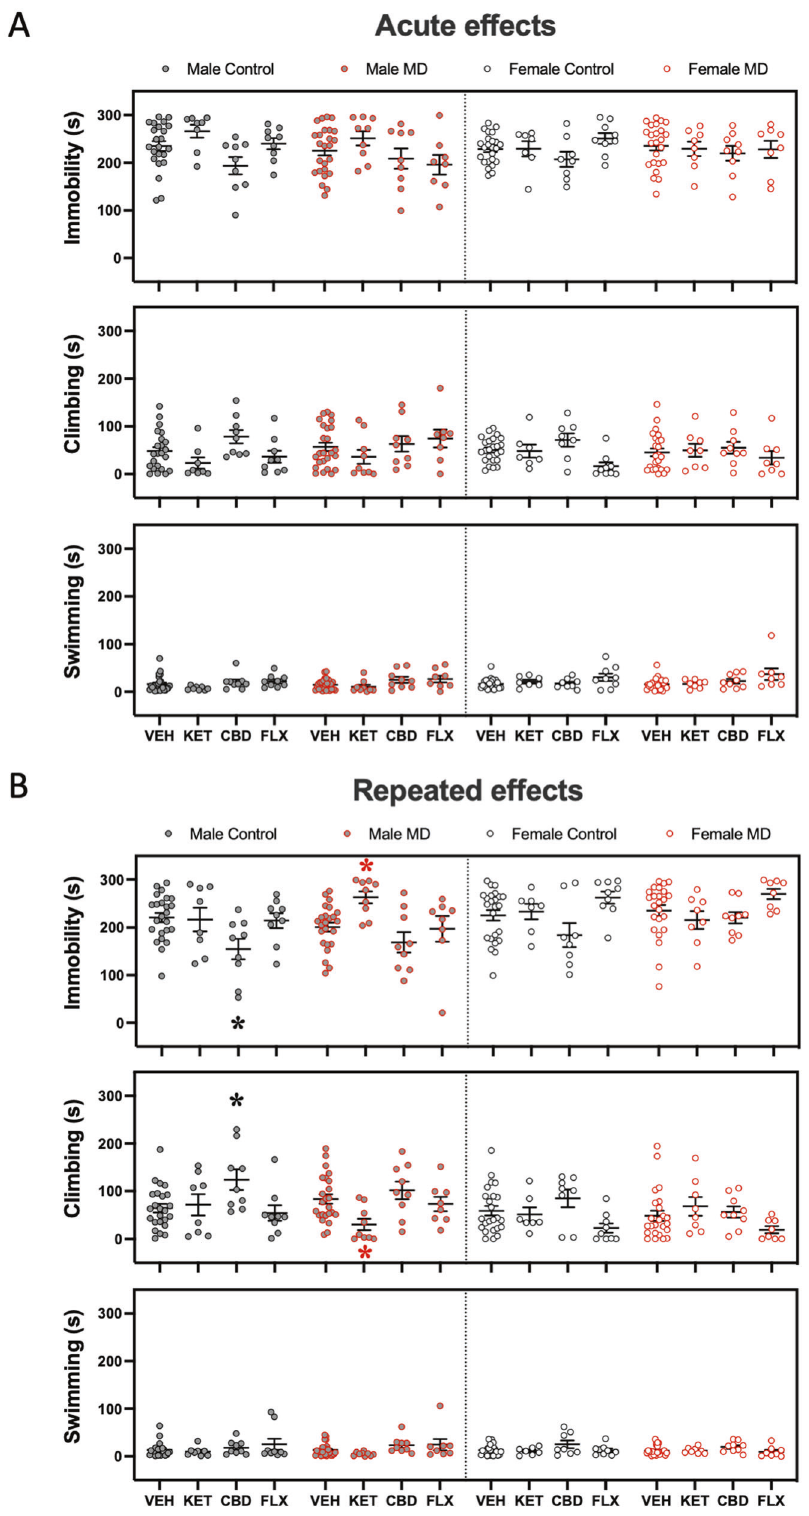
Fig. 4 Antidepressant-like effects as measured in the forced swim test (FST) during adulthood. A Acute (30 min post-treatment) and B repeated (1-day post-treatment) effects exerted by adult ketamine, cannabidiol, or fl uoxetine exposure in male and female rats (Control or MD) in the FST. Data represent mean ± SEM of the time spent (s) immobile, climbing, or swimming. Individual values are shown for each rat (symbols). Three-way ANOVAs (independent variables: sex, early-life, and treatment) and two-way ANOVAs (independent variables: early-life and treatment) are shown in Supplementary Tables 1 and 2 respectively. * p < 0.05 vs. the appropriate control group (Control or MD) and